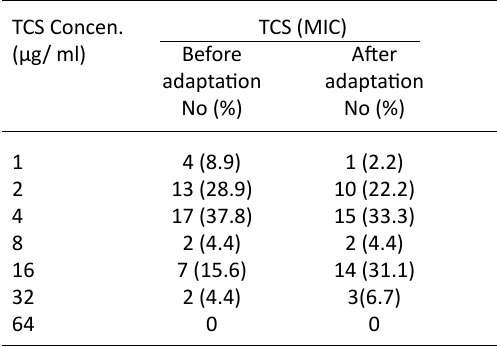
Table 2. Minimum inhibitory concentration (MIC) of TCS for the 45 E. coli isolates